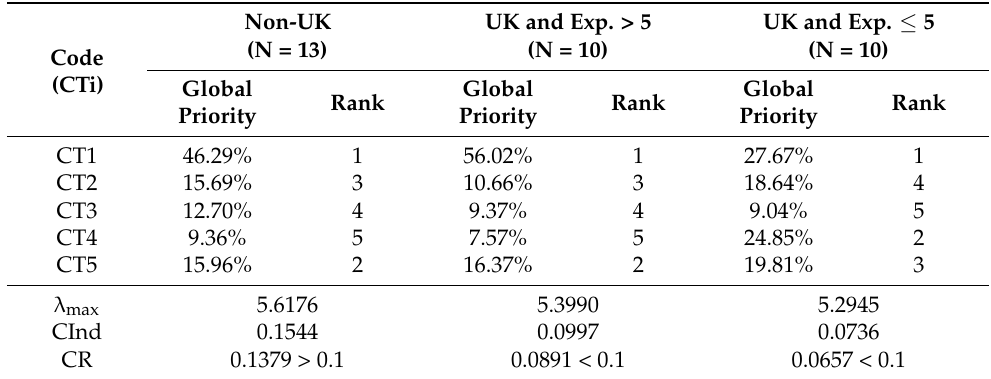
Table 7. Consistency checks of expert judgements in different groups of survey